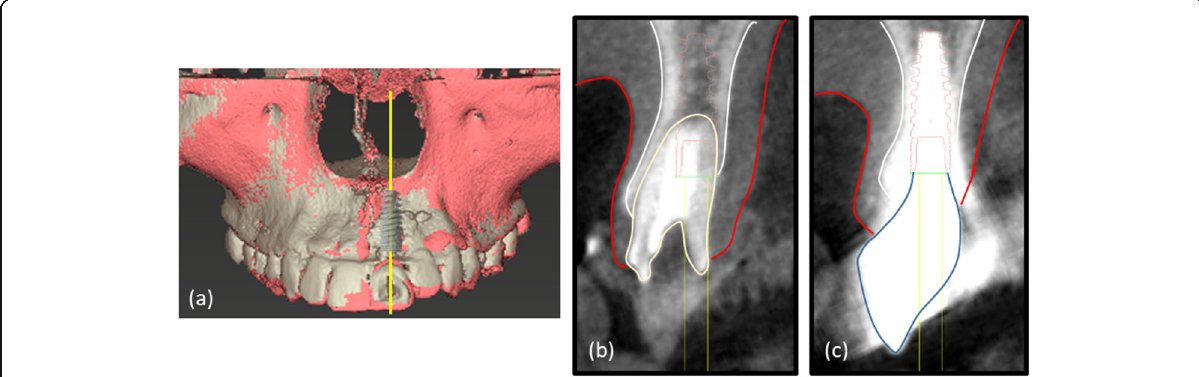
Fig. 2 CBCT image acquisition preoperatively (T0) and 1 year after connection of the definitive prosthesis (T1). a Superimposition of 3D maxillary models obtained from cone-beam computed tomography scans at T0 and T1. b Buccopalatal cross-sectional images at T0 acquired with reference to the long axis of a virtual implant placed in the exact position where the actual implant would be. c Buccopalatal cross-sectional images at T1 acquired with reference to the long axis of the